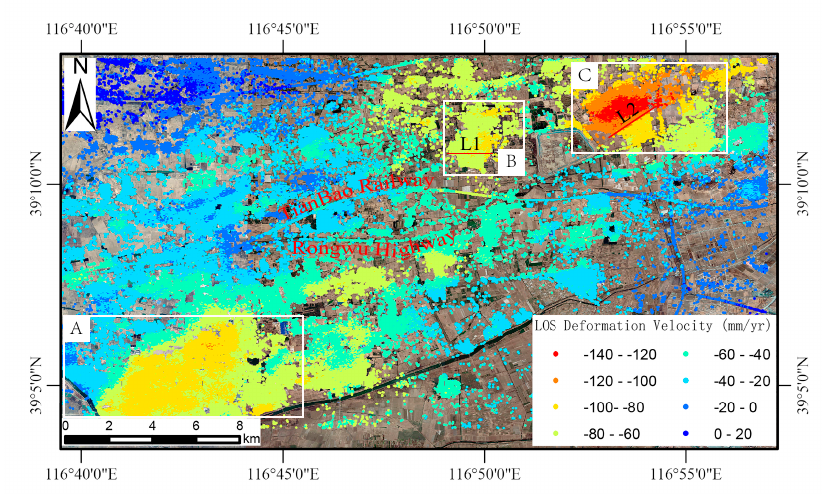
Figure 13. The mean LOS deformation velocity of the subsidence funnel over Part 1 as shown in Figure 12: The white boxes A, B, and C represent Shengfang, Donggugang and Wangqingtuo Town, respectively. The red lines L1 and L2 represent the borders of different subsidence velocities.